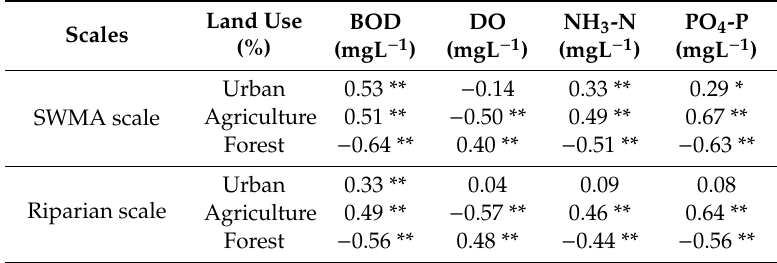
Table 2. Pearson correlations between land use types and water quality parameters at SWMA and riparian bu ff er scales. Land Use BOD DO NH 3 -N Scales (%) (mgL − 1 ) (mgL − 1 ) Urban SWMA scale